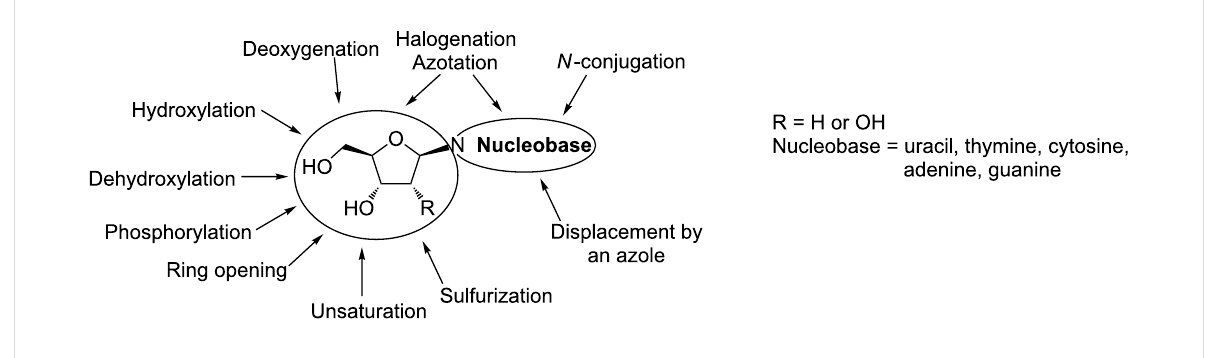
Figure 1: Selected chemical modifications of natural ribose or 2'-deoxyribose nucleosides leading to the development of medicinally important nucleo- side analogs.